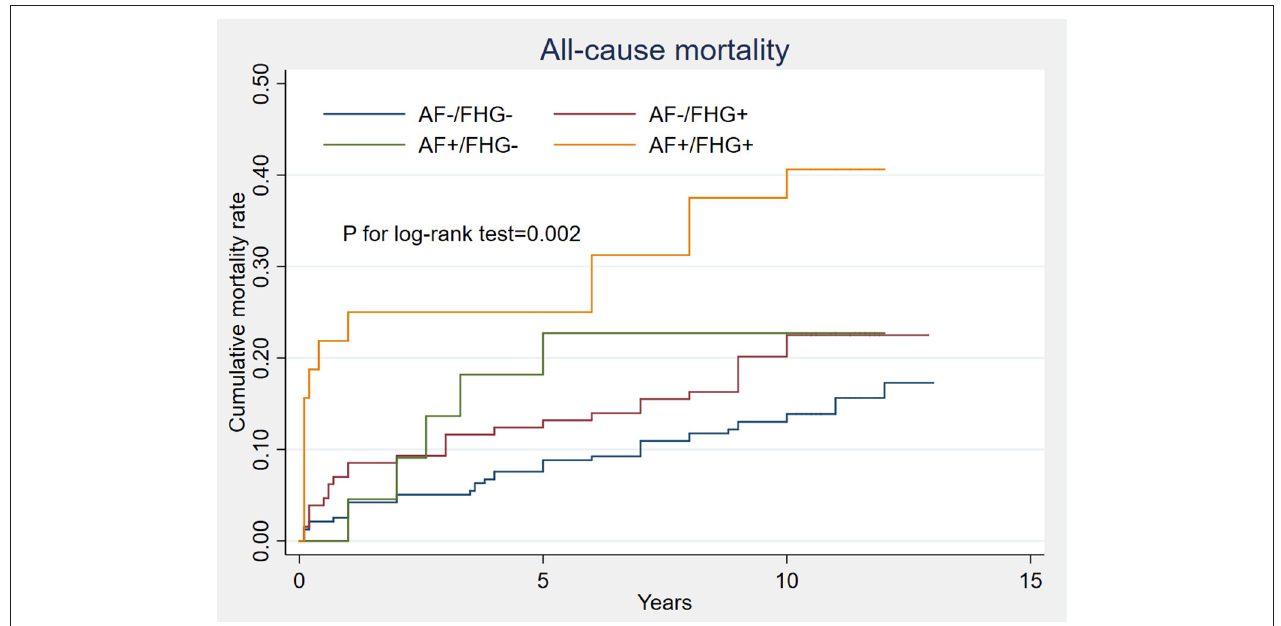
FIGURE 4 | Comparison of long term all-cause mortality under different FHG and new-onset AF status. Kaplan-Meier analysis showed that patients complicated with either FHG (AF–/FHG + ) or AF (AF + /FHG–) had obviously higher cumulative rates of all-cause mortality than those with neither AF nor FHG (AF–/FHG–). Patients complicated with both FHG and AF (AF + /FHG + ) showed the worst long-term all-cause mortality, P for log-rank test was